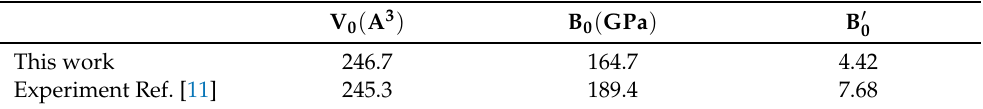
Table 2. Comparison of the calculated and experimental unit cell volume, bulk modulus, and pressure derivative of the bulk modulus at zero pressure.